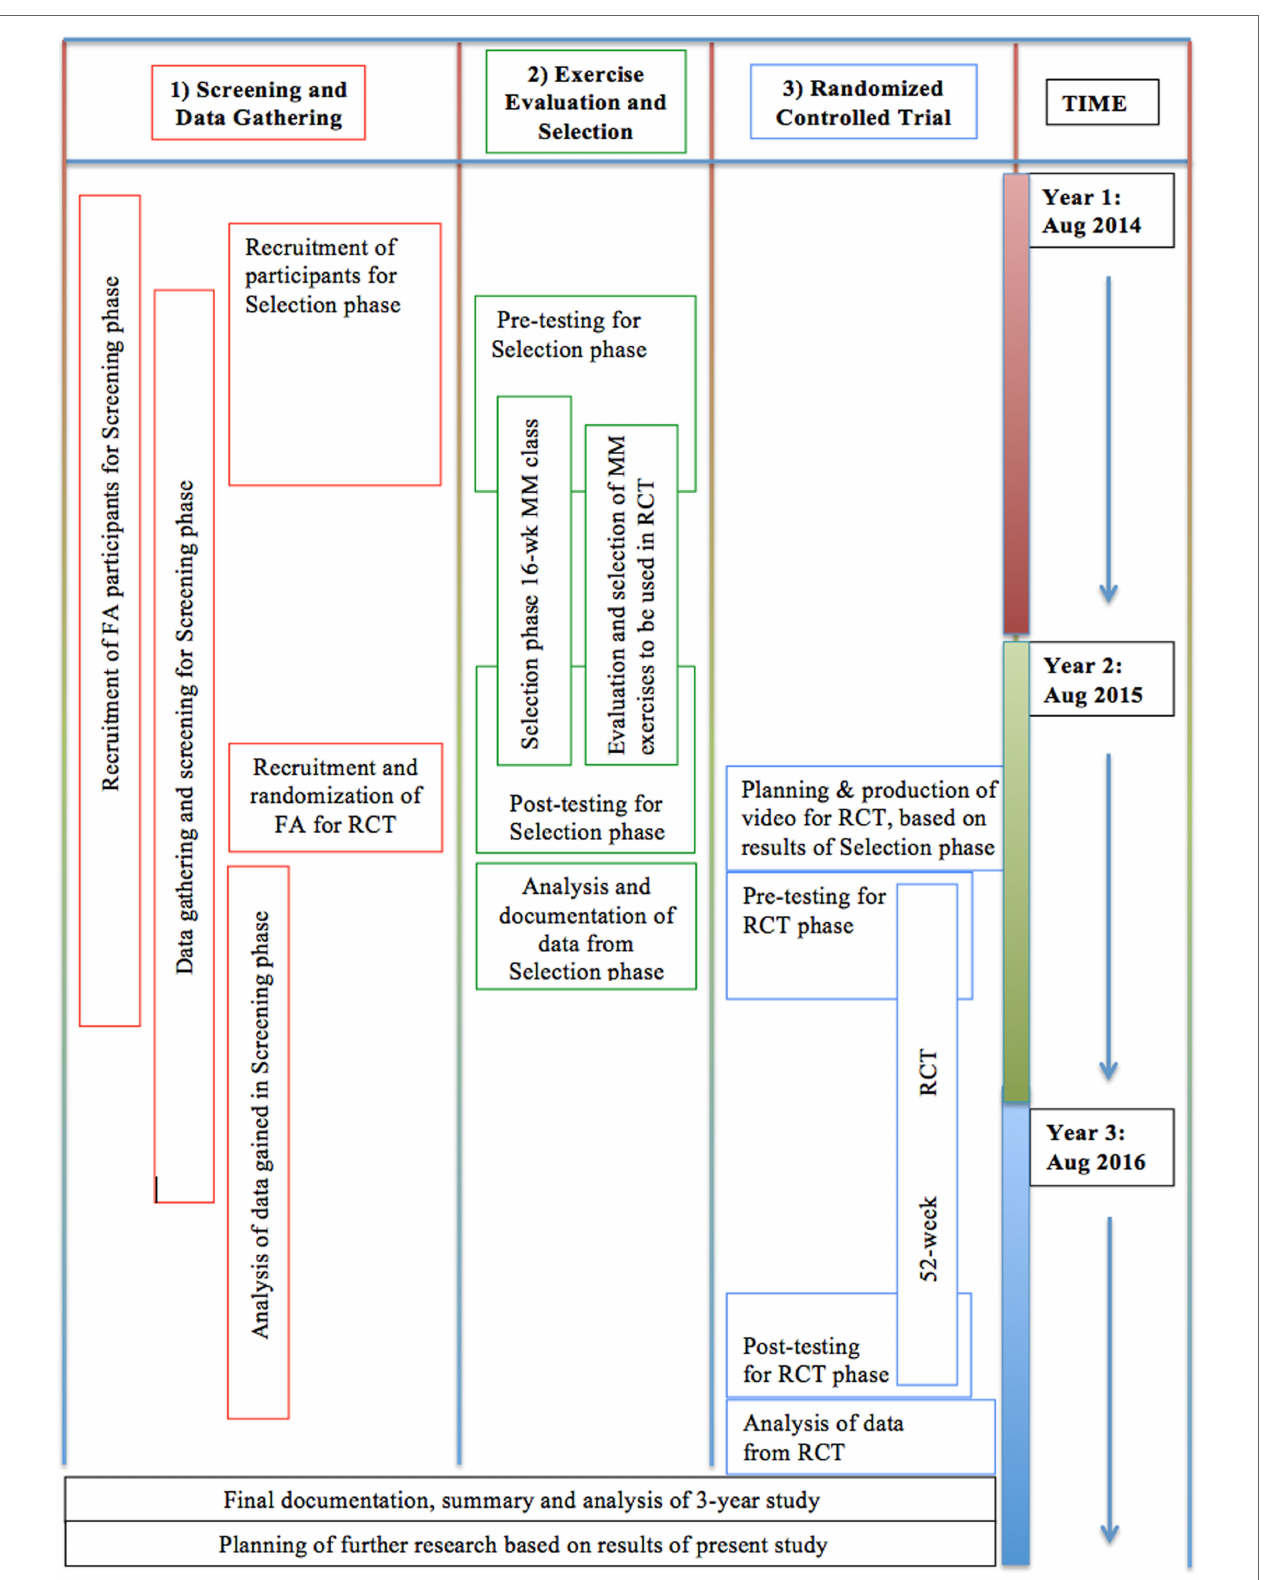
FIGUrE 4 | Proposed timeline for the study